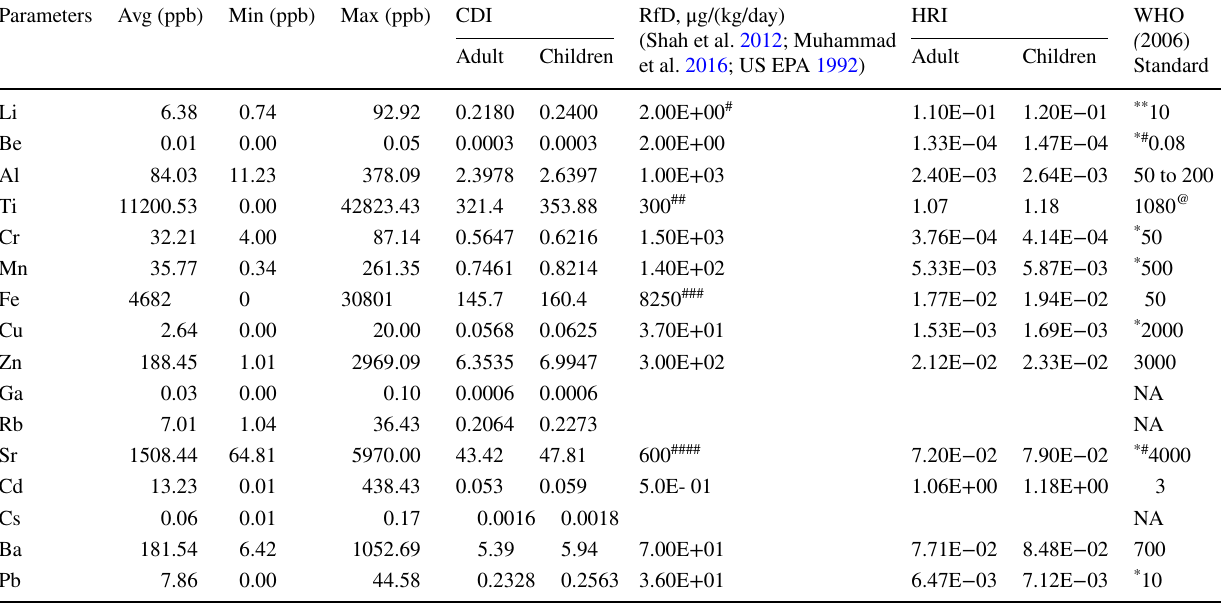
Table 1 Maximum, minimum and mean concentration of trace elements, the mean CDI (µg/kg bw per day) and HRI values of heavy metals in groundwater along with the WHO standard